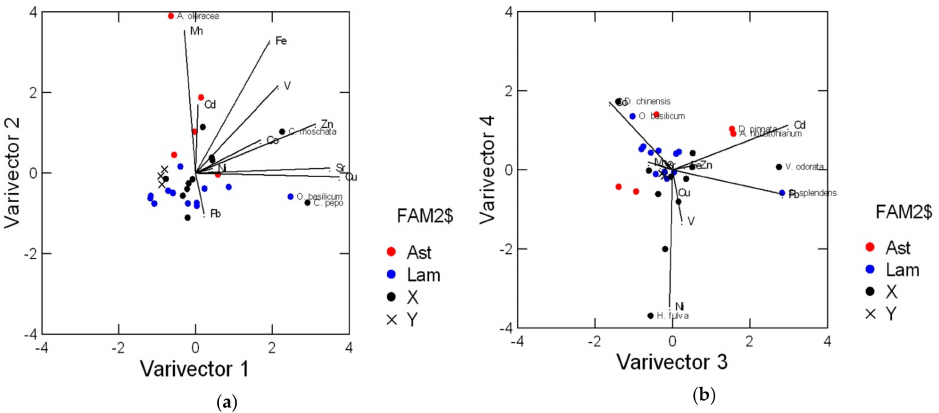
Figure 1. Results of Principal Component Analysis after Varimax rotation, performed on the data matrix of 29 floral species belonging to di ff erent botanical families ( • Asteraceae; • Lamiaceae; • other) described by 10 trace elements. The x symbols indicate snapdragon flowers ( Anthirrinum majus ) of di ff erent colors. Only the names of species at the highest element concentrations are reported. ( a ) Biplot of varivectors 1 and 2; ( b ) Biplot of varivectors 3 and